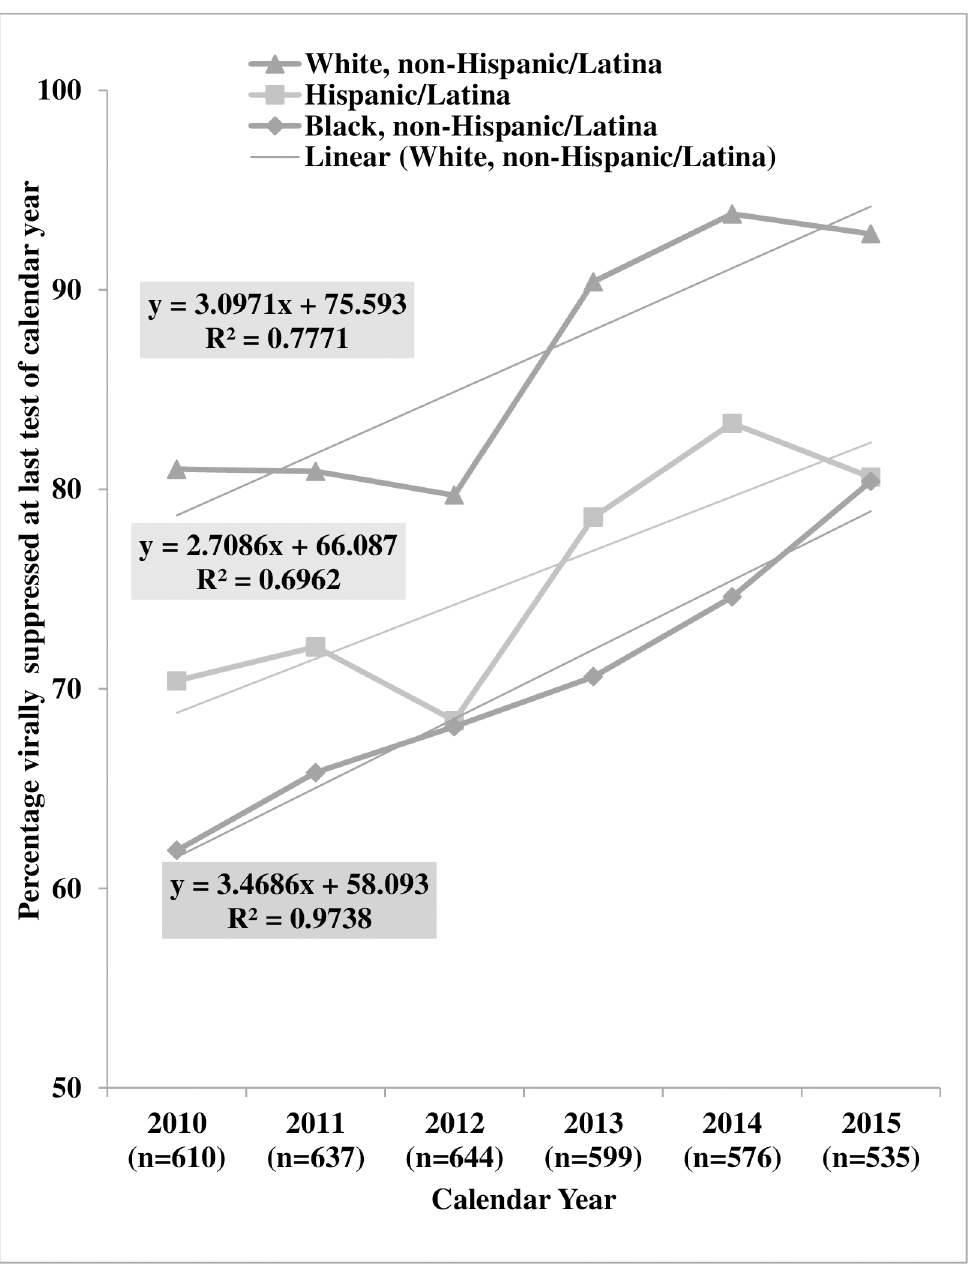
Fig 3. Trends of viral suppression by race/ethnicity, the HIV Outpatient Study, 2010–2015 (N = 809). Prior HOPS cohort analyses have found poorer health outcomes among publically vs. pri- vately insured patients [17] and lower CD4 cell counts soon after HIV diagnosis among HOPS patients accessing care at public vs. private clinics [18], findings that appeared related to sys- tematic differences in the characteristics of patients accessing care at private vs. public clinics. However, lower viral suppression rates among HIV-positive women who attended public clin- ics in our study also suggests that a closer examination of clinical and social supports at public clinics may be warranted. Many public clinics have resource challenges due to decreased staff,